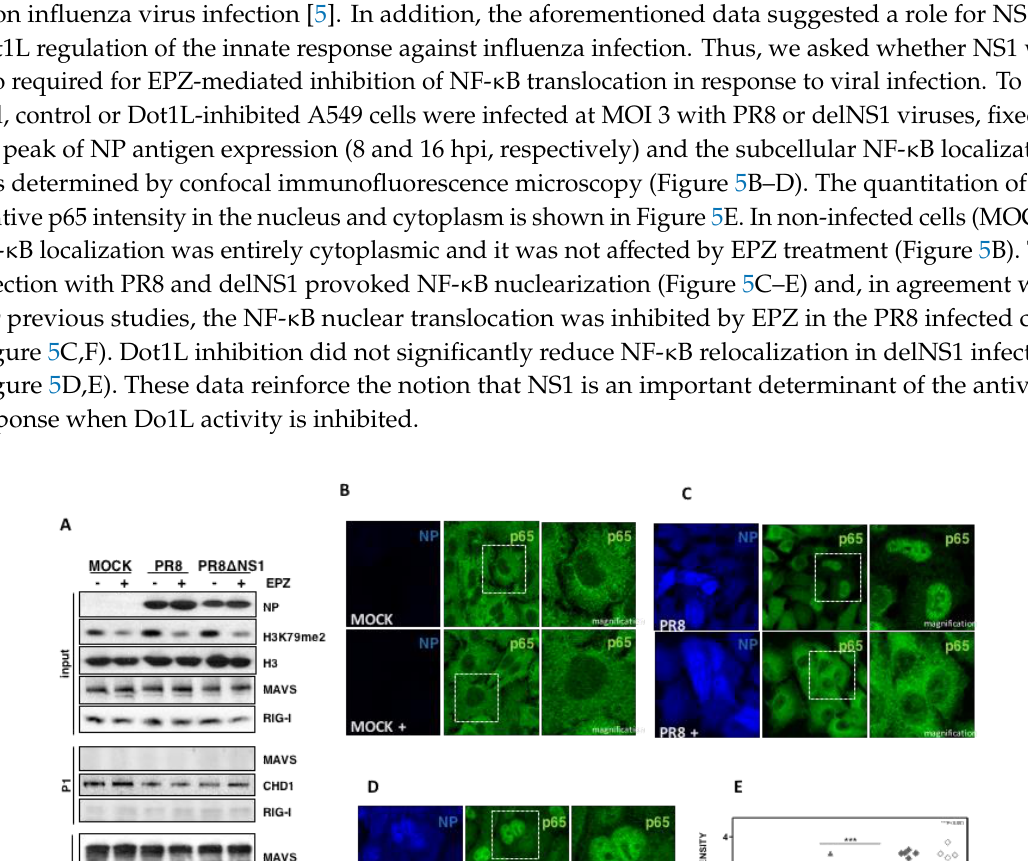
11 of 21 infected cells that were treated or not with the Dot1L inhibitor. Influenza virus infection and the efficacy of EPZ treatment were monitored by determining the accumulation of NP protein levels and total and H3K79 methylated histone 3 content (Figure 5A; Input) in the different conditions. Mitochondria